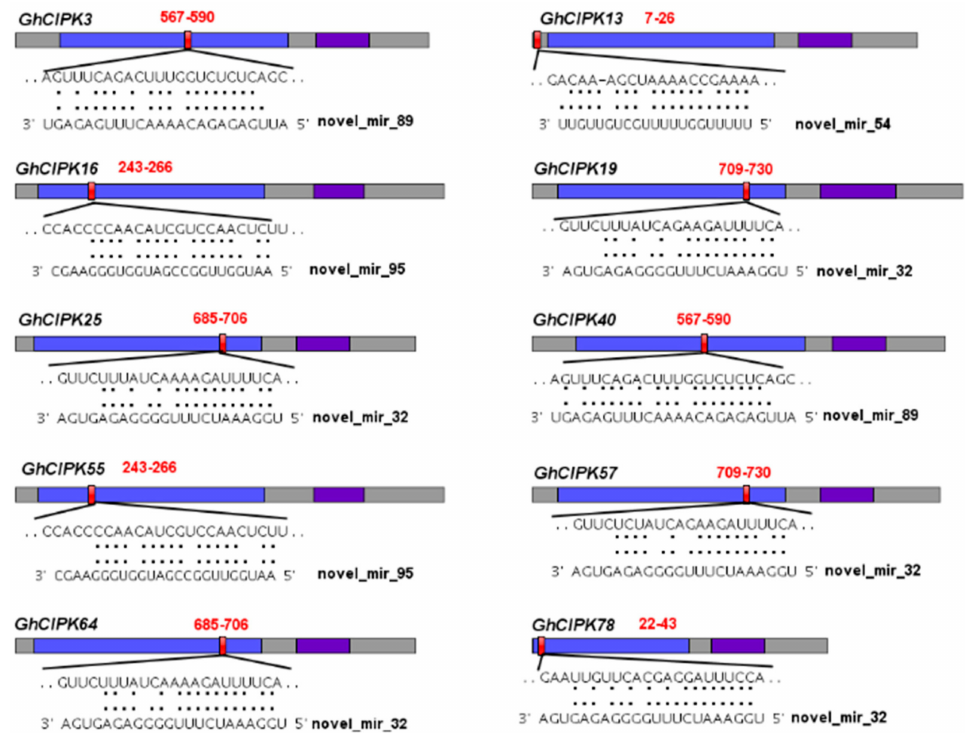
Figure 8. The miRNA-mediated targeting regulatory relationships of GhCIPKs . The ORFs (open reading frames) of GhCIPKs are indicated by heavy grey boxes. The protein kinase domain (PF00069) and the NAF domain (PF03822) are shown in blue and purple boxes, respectively. miRNA complementary sites with the nucleotide positions of CIPK genes are filled by the color